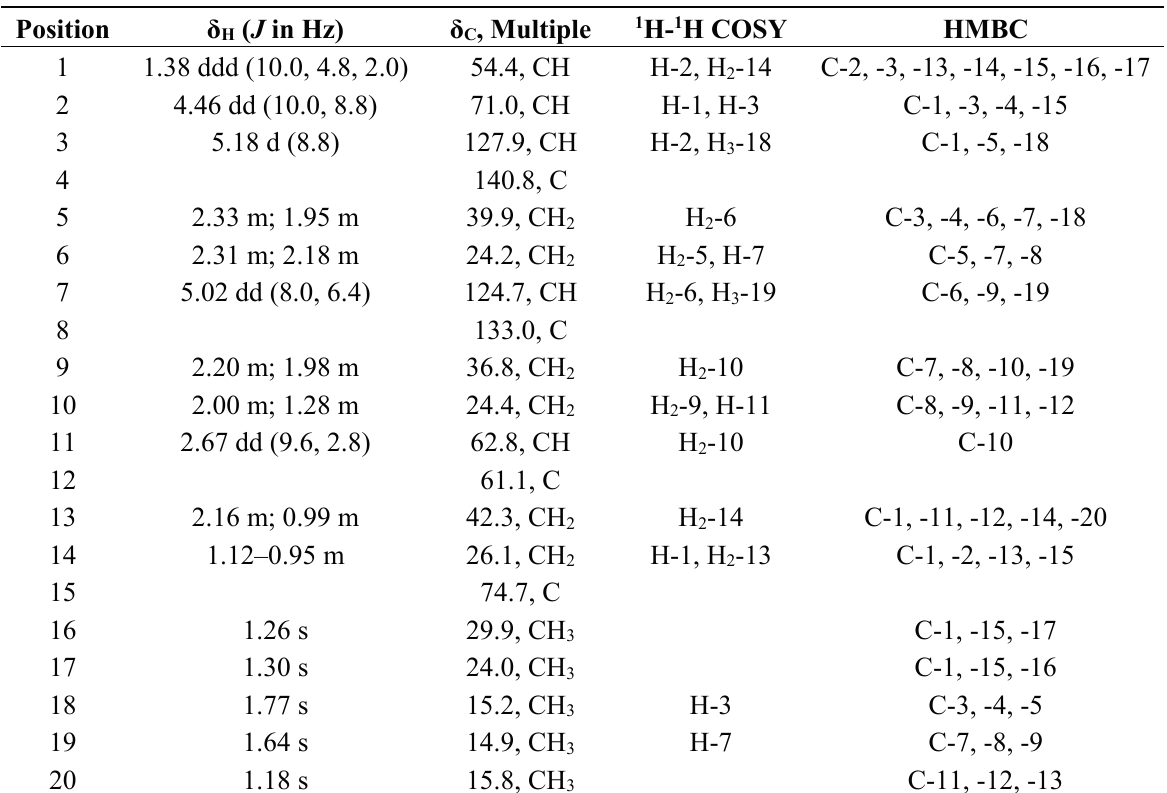
Table 2. 1 H (400 MHz, CDCl 3 ) and 13 C (100 MHz, CDCl 3 ) NMR Data, 1 H- 1 H COSY and HMBC correlations for cembrane 2